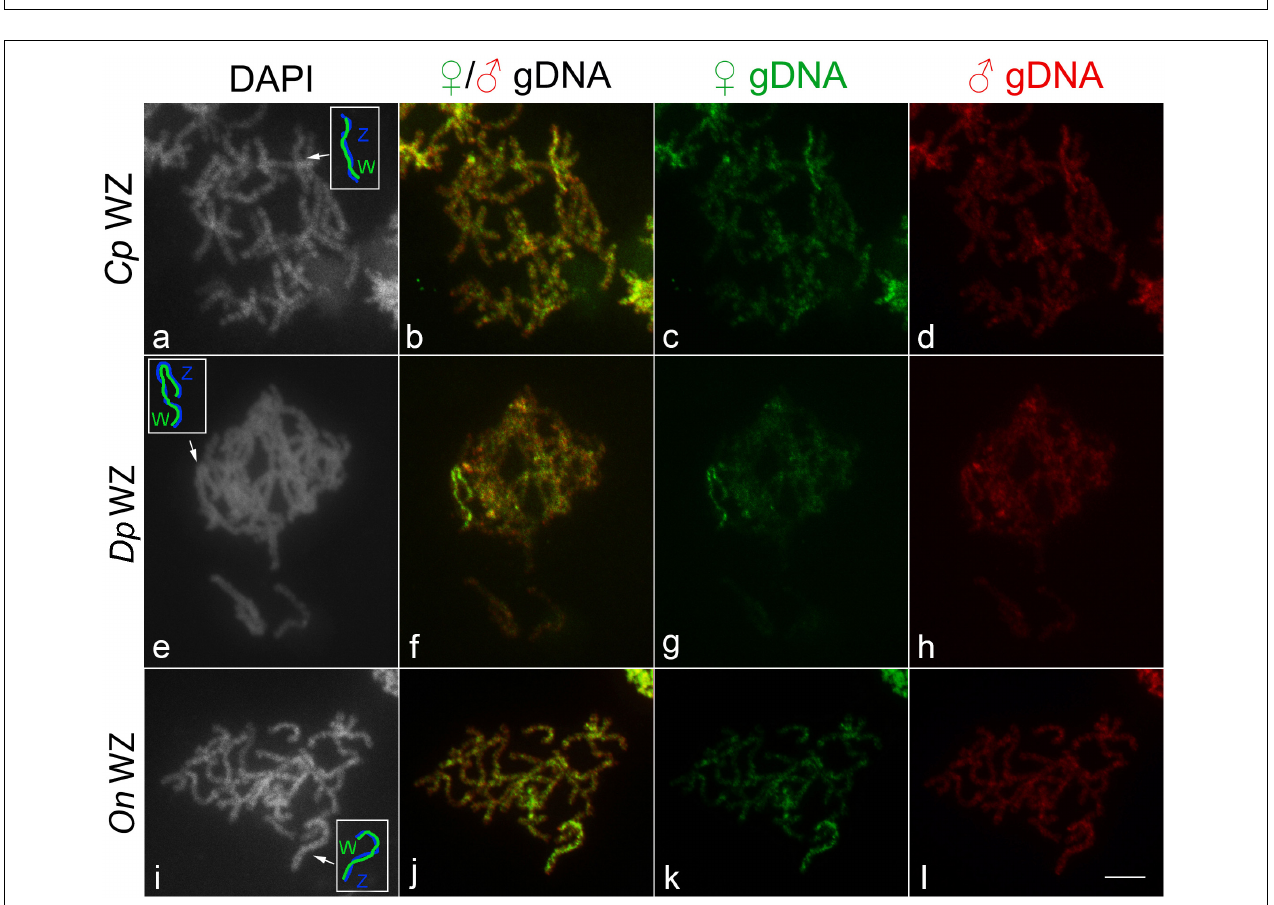
FIGURE 1 | FISH mapping of 18S rDNA clusters in male pachytene bivalents of Cydalima perspectalis (a) , Diatraea postlineella (b) , and Ostrinia nubilalis (c) . Chromosomes were counterstained with DAPI. Arrows indicate hybridization signals of the probes (red). The inset in panel (b) shows two homologous mitotic chromosomes from a D. postlineella spermatogonium with signals of the 18S rDNA in the interstitial position. Bar = 10 µ m.